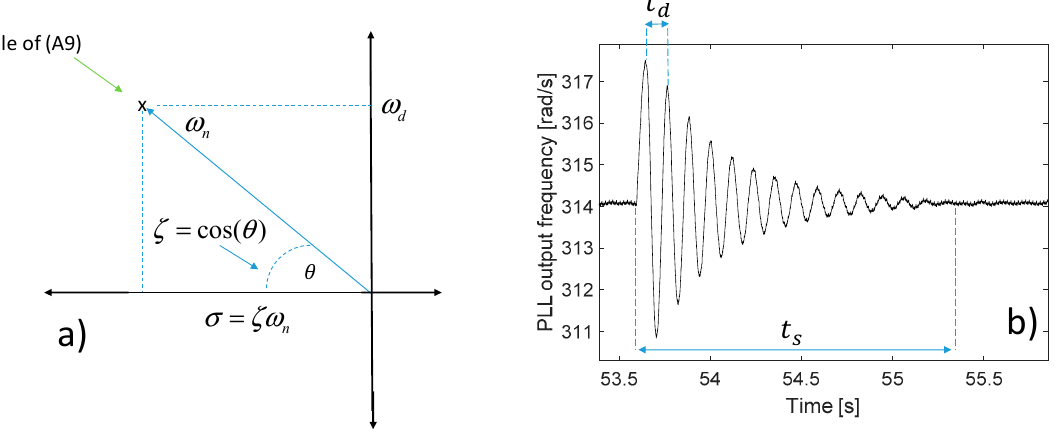
Figure A1. ( a ) pole diagram of Equation (A9), and ( b ) experimental measure of (A10) from the experimental system.